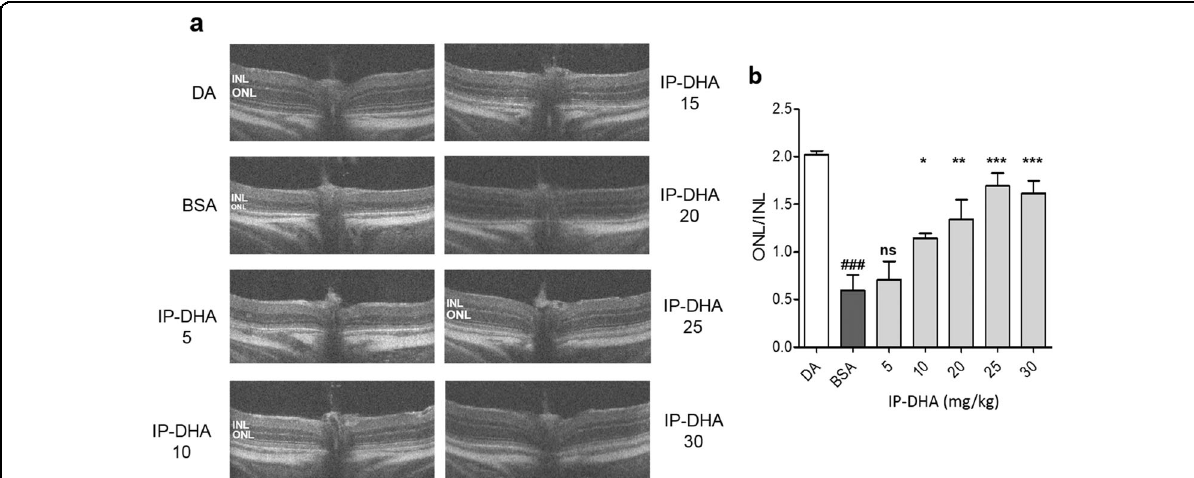
Fig. 3 SD-OCT imaging after light-induced acute retinal degeneration. a SD-OCT images show reduced thickness of the ONL 5 days after light exposure in Abca4 − / − mice administered BSA (vehicle), whereas those receiving 25 mg/kg IP-DHA (IP-DHA 25) exhibited an ONL thickness similar to that of nonexposed mice (DA). b The protective effect of IP-DHA was dose dependent, with signi fi cant differences observed with doses ≥ 10 mg/kg. Abca4 − / − mice treated with 25 mg/kg IP-DHA recovered 80 – 85% of ONL thickness, whereas no protection was observed in BSA-treated mice (BSA). The data are represented as the mean ± SEM from n ≥ 5 mice. One-way ANOVA with Bonferroni ’ s multicomparison posttest: ### p < 0.001 BSA vs. DA; * p < 0.05, ** p < 0.01, *** p < 0.001 IP-DHA vs. BSA; IP-DHA 5 vs. BSA nonsigni fi cant,